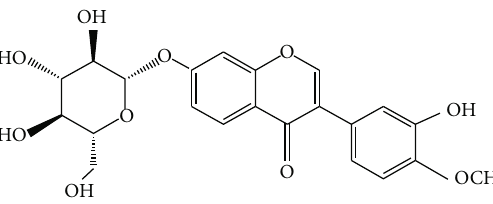
Figure 1: Structure of Calycosin-7- O - β - D